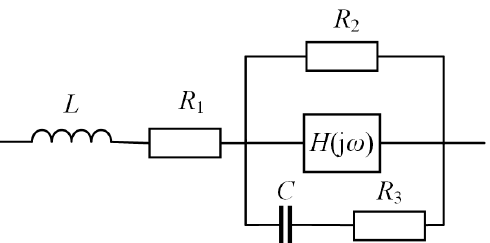
Figure 3. Fractional-order supercapacitor topology using the Havriliak–Negami function.